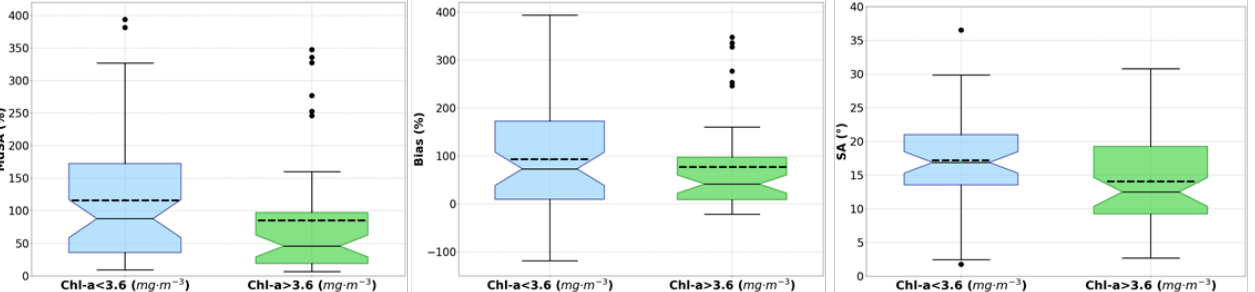
Figure 7. Box plots referring to the Chl-a concentration (3.6 mg·m − 3 represents the median value). The box plot in blue is representative of water types with clear water characteristics while the box plot in green is representative of phytoplankton-rich waters (i.e., with a Chl-a concentration >3.6 mg·m − 3 ). The continuous line represents the median while the dashed line represents the mean.